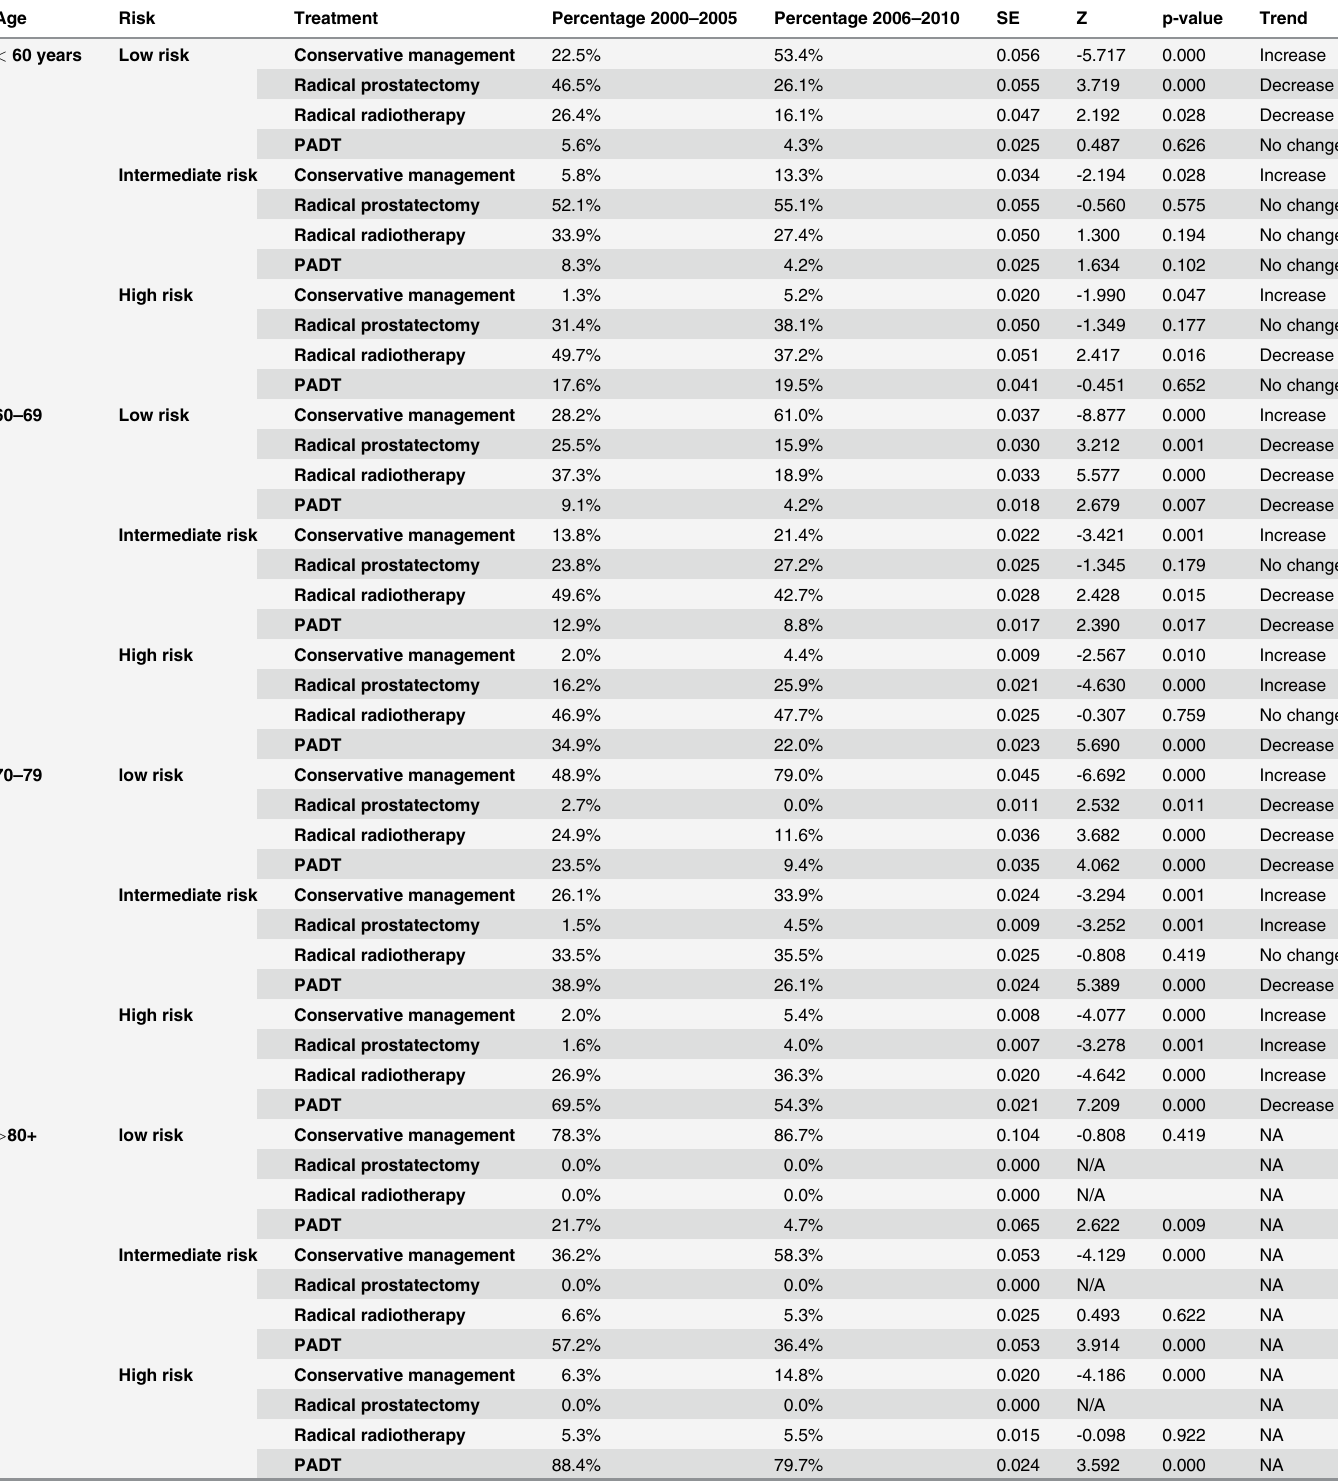
Table 3. Incidence rate changes in prostate cancer treatment modality for non-metastatic disease strati fi ed by age and NICE risk group between 2000 – 2005 and 2006 –